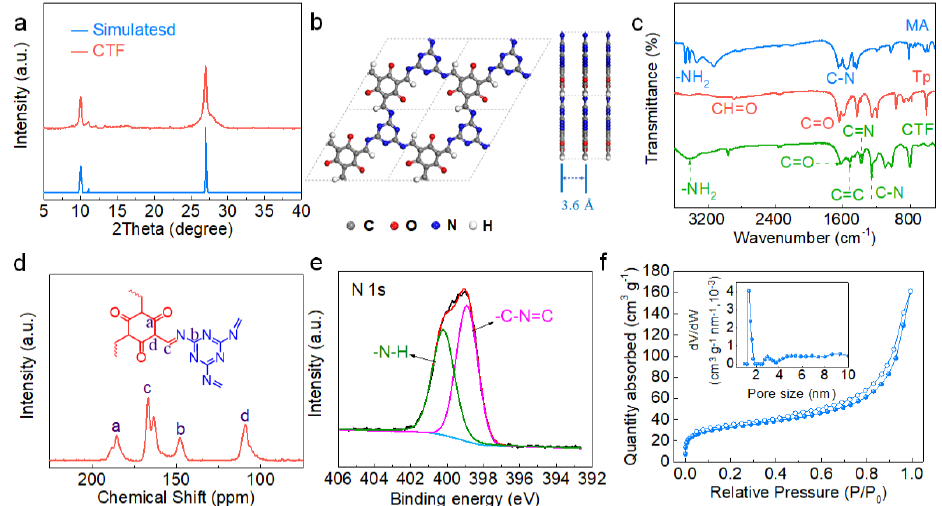
Figure 2. Structural characterization of the CTF: ( a ) XRD of experimental pattern and simulated pattern; ( b ) Structural models of the CTF with quasi-AA stacking; ( c ) FT-IR spectra of the CTF and precursor; ( d ) 13 C CP/MAS solid-state NMR spectra; ( e ) High-resolution N 1s XPS spectra; ( f ) N 2 adsorption–desorption isotherms of the CTF (insets: pore size distribution curve).